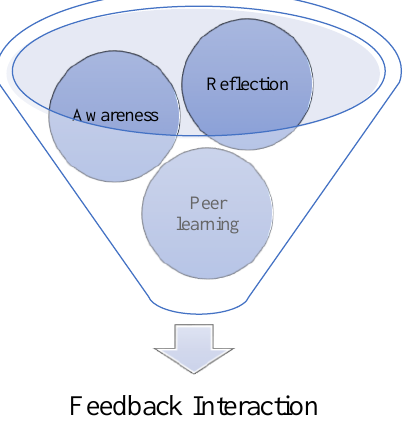
Figure 2: Eportfolio pedagogy and key constructs of feedback